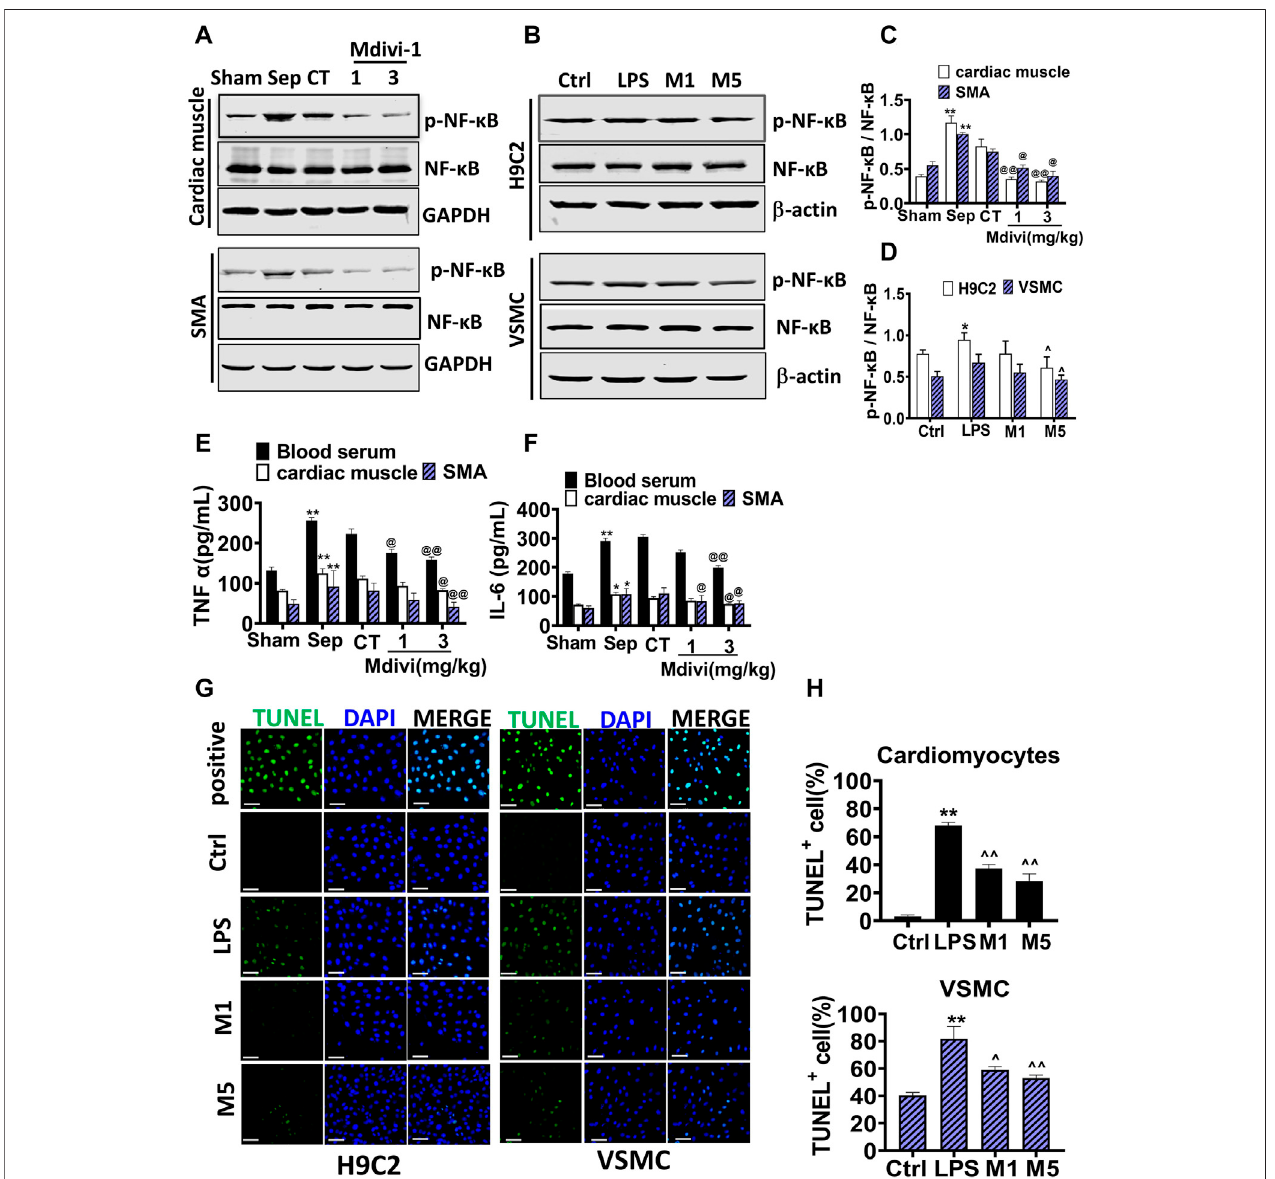
FIGURE5| Effects ofMdivi-1onin fl ammatoryresponseandapoptosis inseptic rats. (A – D) :Western blotand statisticalanalysisofthephosphorylationofNF- κ B. (E) : the concentration of TNF- α in blood serum, cardiac muscle and superior mesenteric arteria. (F) : the concentration of IL-6 in blood serum, cardiac muscle and superior mesentericarteria. (G,H) : Effects ofMdivi-1 on apoptosis in cardiomyocytes and VSMC(bar (cid:1) 50 µm). * p < 0.05, ** p < 0.01 versus sham or ctrl. @ p < 0.05 and @@ p < 0.01 versus conventional treatment (CT) group. Sham (cid:1) the control group, Sep (cid:1) sepsis, CT (cid:1) conventional treatment. 1: Mdivi-1 (1 mg/kg). 3: Mdivi-1 (3 mg/kg).SMA:superiormesentericarteria.H9C2:cardiomyocytes.VSMC:vascularsmoothmusclecell.Ctrl:controlgroup.M1:Mdivi-1(10 µM).M5:Mdivi-1(50 µM).